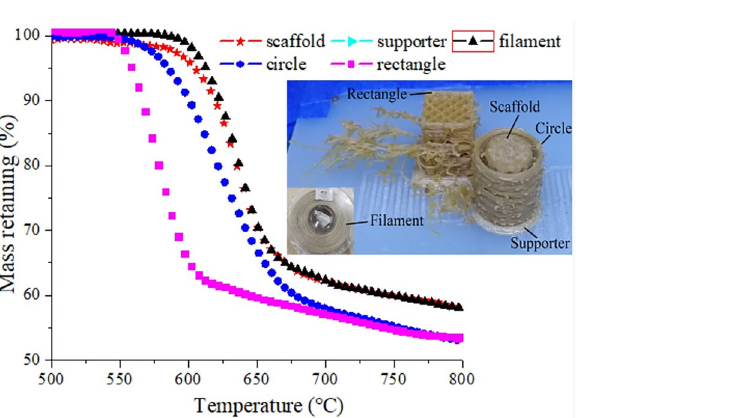
Figure 6. Procedure of the PEEK-PLA/WS/HA composite scaffolds.